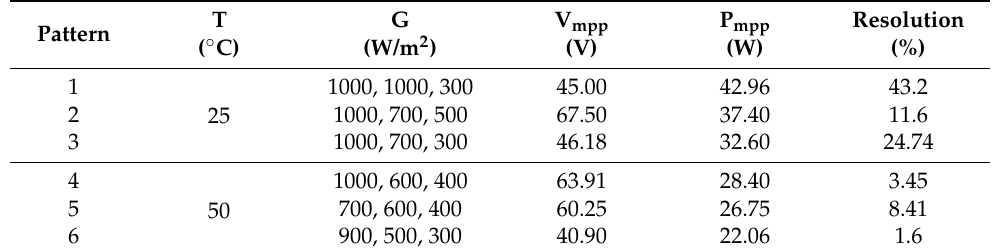
Table 3. Six test patterns.